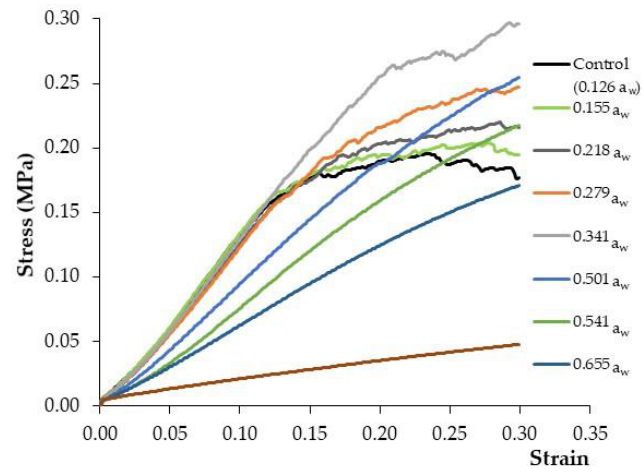
Figure 6. Stress – strain profile of commercial puffed corn cakes (PCC) stored using different salts to reach a wide range of water activity (a w from 0.1 to 0.8) and compared with the control sample (0.126 a w ). At high a w values, from 0.50 to 0.85, the elastic behaviour is more noticeable at higher strains [23] and the plastic zone is displaced to greater strain values in some cases (a w 0.836), beyond the experimental range. In addition, curve smoothing was manifested at high moisture contents, which is a characteristic property of soft materials where microfractures are not easily produced. This is related to the reduction in the frequency of small and random fractures in the PCC during the flexion–compression test. In this sense, Li et al. [5] reported that corn cakes with an a w value of under 0.3 presented irregular jagged force-time curves, whereas the profile of samples above 0.5 a w showed a smooth